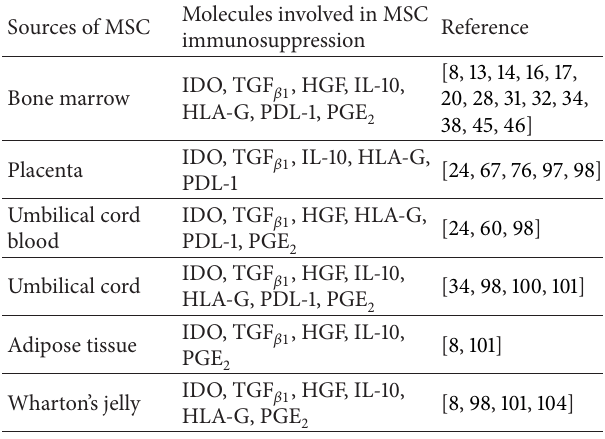
Table 1: Description of the molecules involved in immunoregula- tion mechanisms by MSCs from different